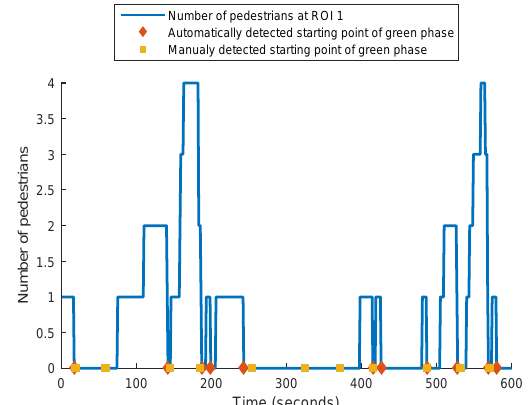
Figure 7: Sub-section of automatically tracked pedestrians at ROI#1 and ROI#2 with starting points of green phase considering one second reaction time.